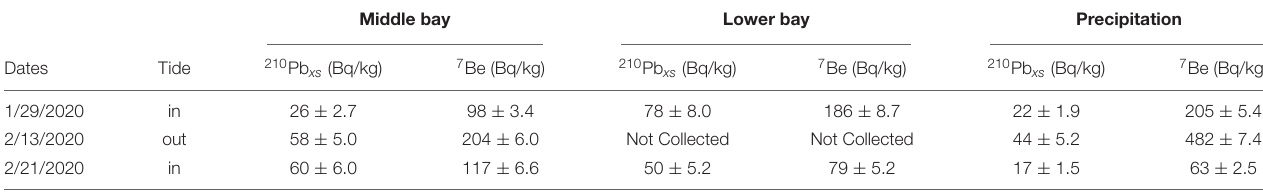
TABLE 1 | 210 Pb xs and 7 Be Activities (Bq/kg) in Suspended Sediment and Precipitation samples. Middle bay Lower bay